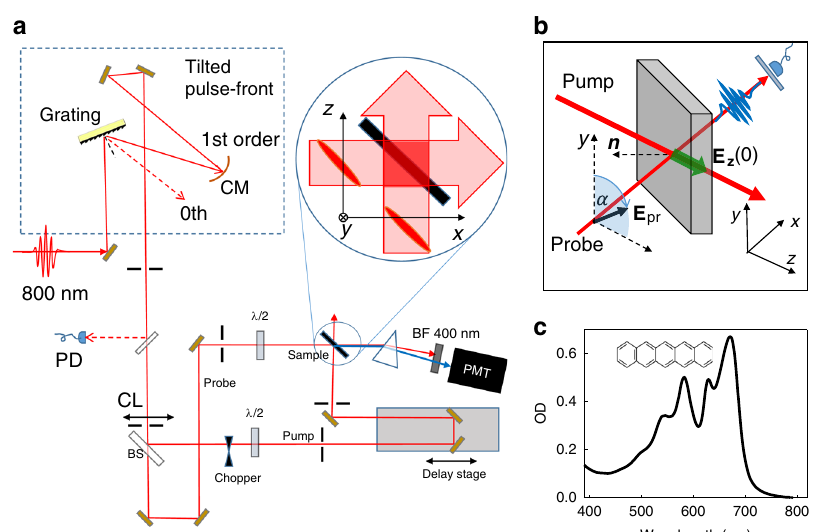
Fig. 1 Experimental setup and sample characterization. a Schematic of the crossed beam pump-probe experiment for detection of magneto-electric recti fi cation. The dashed rectangle depicts a controller for tilting the pulse-front that consists of a grating, a cylindrical concave mirror (CM), and a pair of fl at mirrors. The fi rst order laser beam from the grating passed through a cylindrical lens (CL). The CM and CL mirrors provided chirp and dispersion correction, respectively. The beam splitter (60/40) then split the incident laser beam into pump and probe pulses. Half-wave plates ( λ /2) were used to control polarization. SHG signal was detected by a photomultiplier tube (PMT) through a prism and a bandpass fi lter (BF) centered at λ = 400nm. A magni fi ed top view of the sample region (circular inset) shows the tilted pump and probe pulses approaching the interaction region of the sample. A photodiode (PD) was used to synchronize the laser with the chopper. b A 3D view of the beam geometry. Probe polarization angle α is measured with respect to the y axis. n is the surface normal. The wide green arrow represents the forward pump-induced recti fi cation electric fi eld, E z (0). c Absorption spectrum of the pentacene sample, showing the absence of absorption at 800 nm and weak absorption at the 2-photon absorption wavelength of 400 nm. OD = optical density.